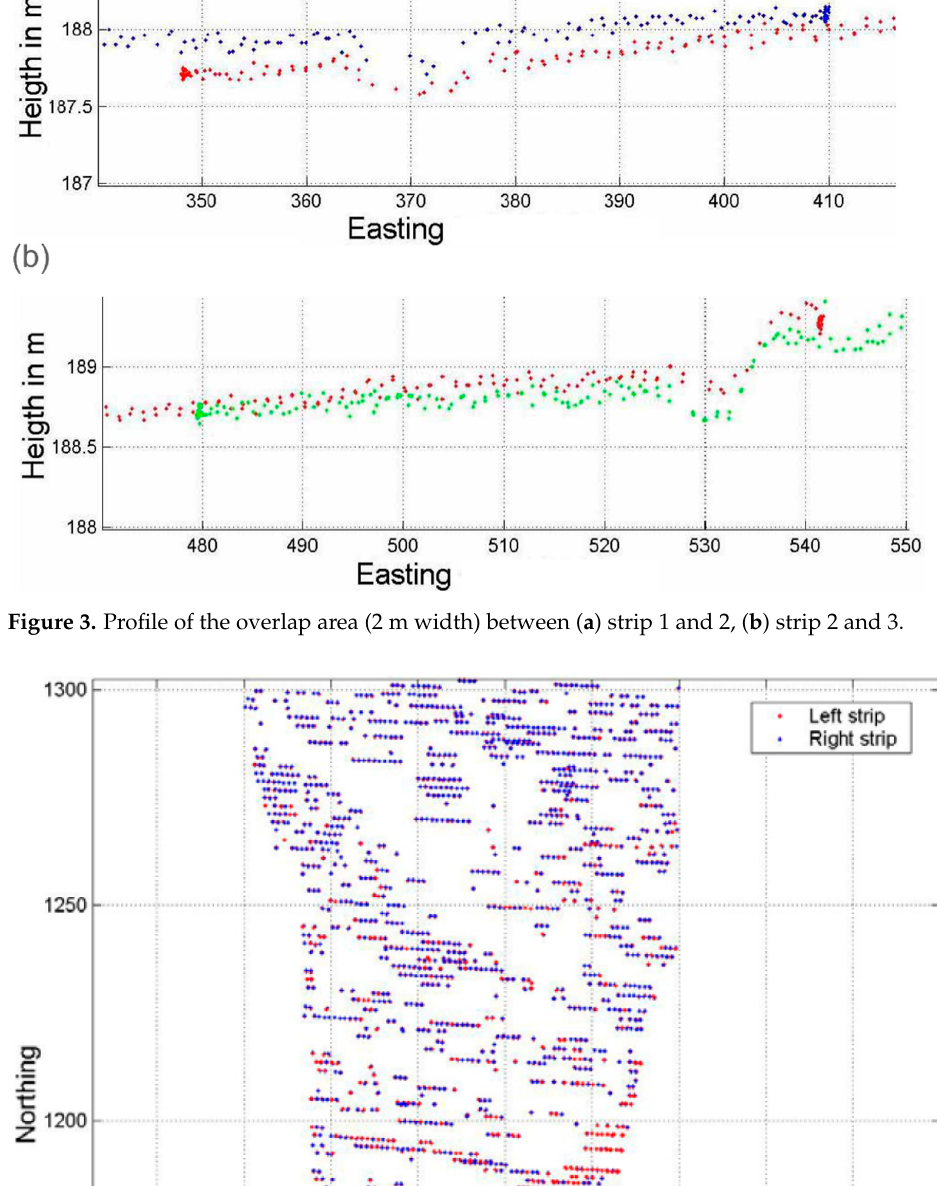
Figure 3. Profile of the overlap area (2m width) between ( a ) strip 1 and 2, ( b ) strip 2 and 3. Relative Height Offset